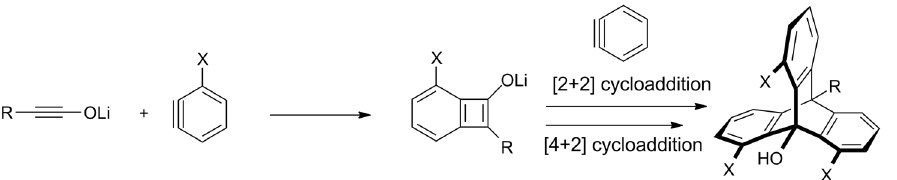
Table 1. Selected experimental 1 J (Si,C Ph ) and 1 J (H,Si) spin–spin coupling constants (Hz) within the -SiH 2 (Ph) group of two rotamers (see Figure 2) of TRPCl.